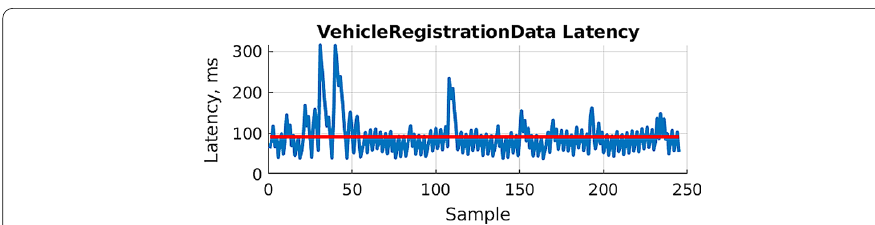
Fig. 7 Application‑level latency of the vehicle registration signal measured in the